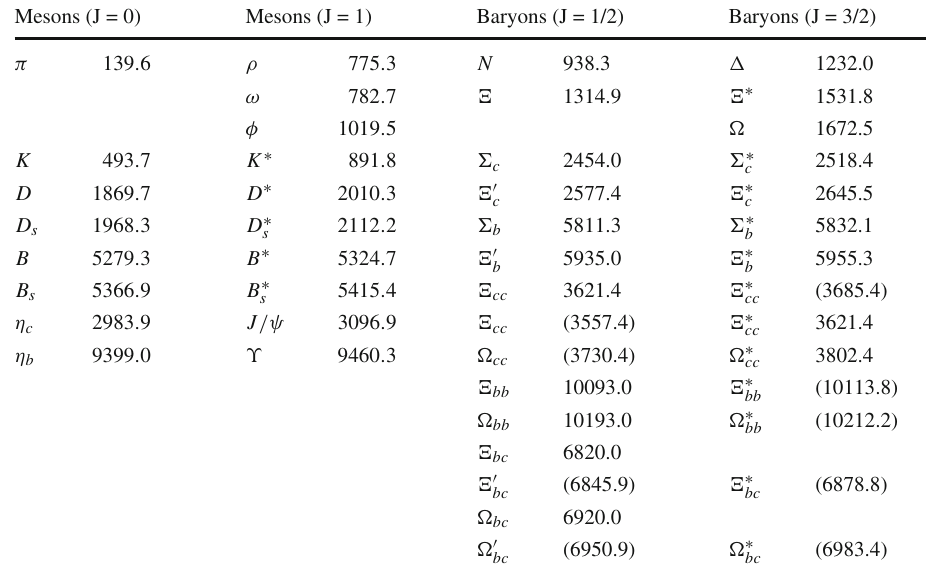
Table 3 Used masses of the conventional hadrons in units of MeV [38]. Since the spin of the (cid:2) cc observed by LHCb may be 1/2 or 3/2, we show results in both cases. The adopted masses of other doubly heavy baryons are taken from Refs. [39–42] ( (cid:6) ∗ cc is from Ref. [27]). The values in parentheses are obtained with the parameters